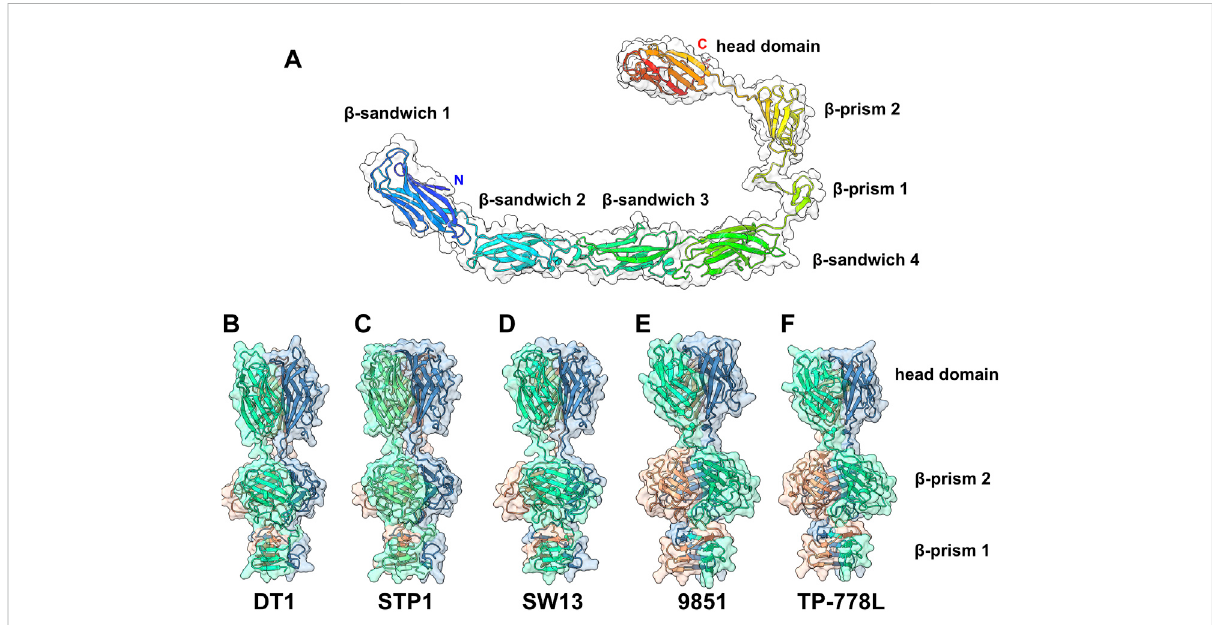
FIGURE 4 Predicted structure of the RBPs. (A) Ribbon and transparent surface representation of TP-778L RBP predicted monomer structure comprising, from the N- to the C-terminal parts, four structural β -sandwiches, two β -prism domains, and the C-terminal head domain. (B – F) Ribbon and transparent surface representation of the trimeric β -prisms and C-terminal head domains from the fi ve phages under study (colored by